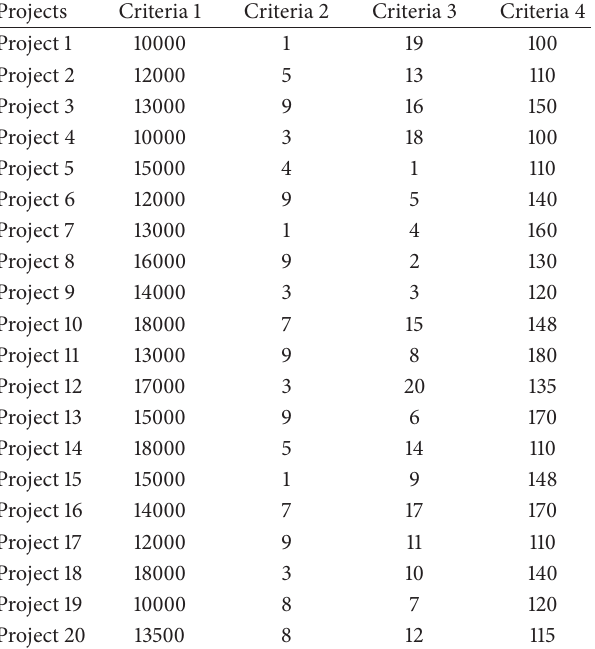
Table 4: The input data of the 20 projects under